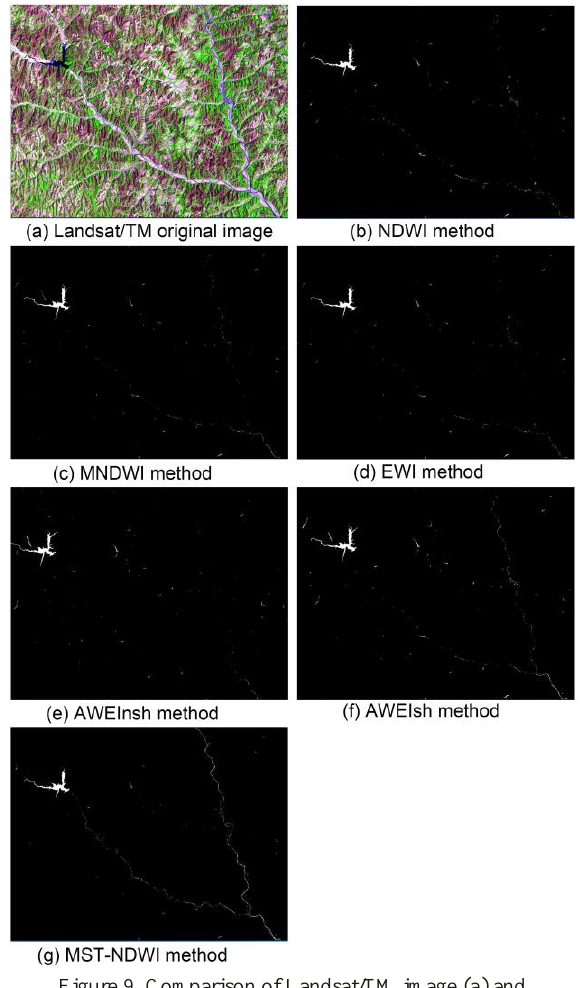
Figure 9. Comparison of Landsat/TM image (a) and conventional Water Index analysis (b)-(f) with the result of MST-NDWI (g) in the upper reaches of Yanhe River In the middle reaches of Yanhe River (Fig.10), the results illustrate that the water extracted by AWEI nsh method is linear, but it's also intermittent. In addition, on the areas outside the screenshot, it is obvious that many background objects were false-extracted. In the water extraction maps of NDWI, MNDWI, EWI, and AWEI sh methods, the built-up land in Yan'an City, which is a blue-purple region in the original image of Landsat TM, is false-extracted as water, resulting in a chaotic water mapping and vague line feeling. Especially, the results of NDWI, MNDWI and EWI, show that the linear rivers in the east cannot be shown at all. However, the water extracted by MST-NDWI method is a smooth line with uniform thickness and less